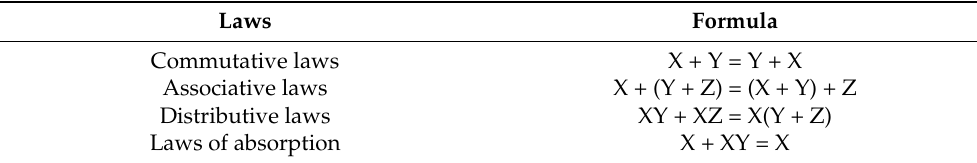
Table 2. Boolean algebra fundamental laws.